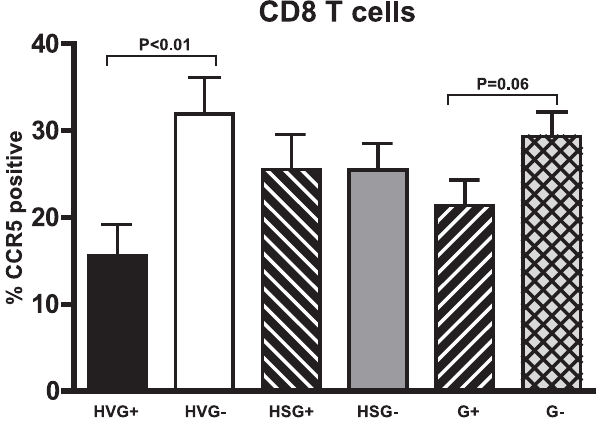
Figure 6. GBV-C is associated with reduced CCR5 expression on CD8 + T cells in HIV-infected subjects. The percentage of CCR5 + CD8 + T cells appeared to differ between subjects with HIV viremia (HV) with GBV-C viremia (HVG + ) compared to those without GBV-C viremia (HVG-). This difference was not observed in subjects receiving cART.